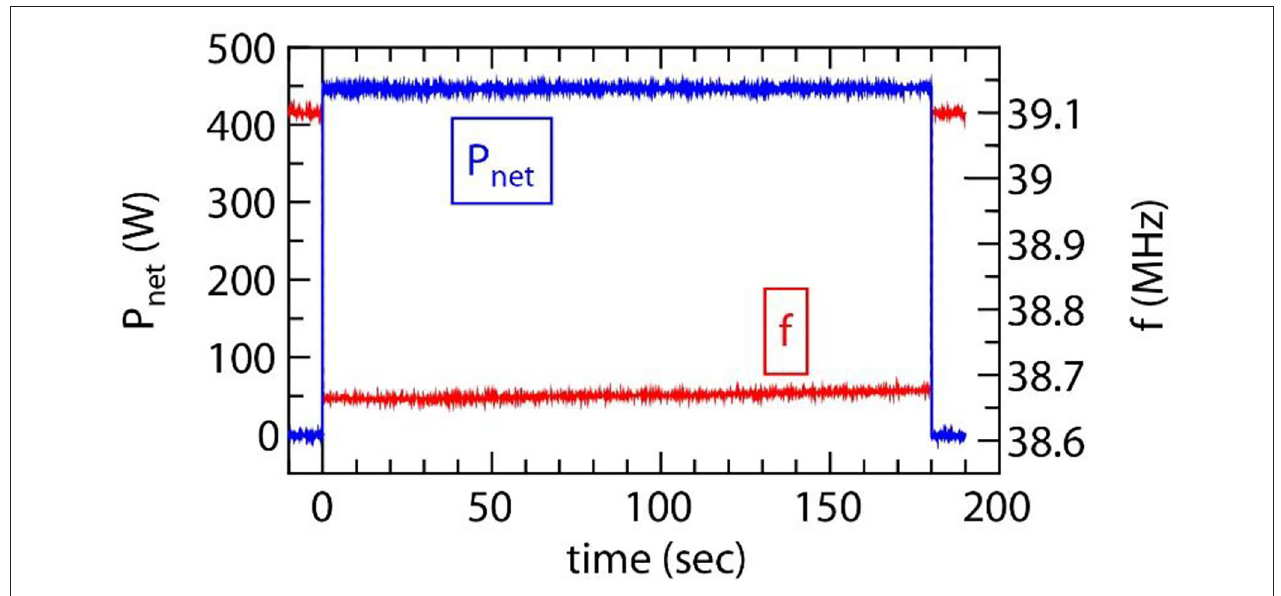
FIGURE 5 | Temporal evolutions of the net power P net (a blue solid line) and the rf frequency f (a red solid line), where the pulse width and the target value of the net power are set at 180s and 450W, respectively.